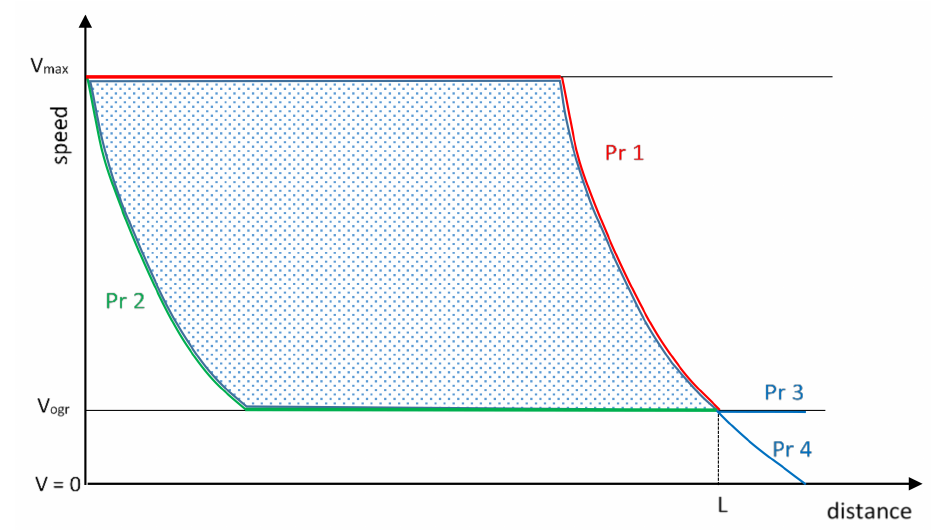
Figure 3. A set of acceptable solutions for the braking train (source: own